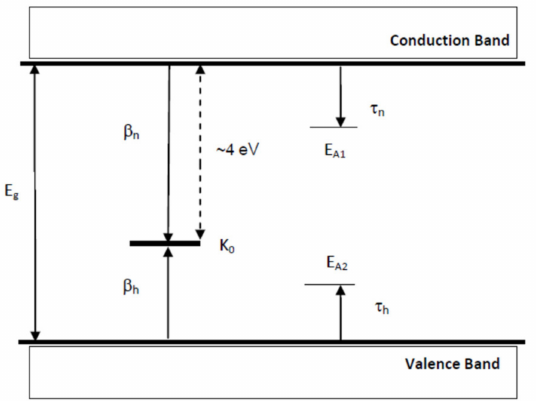
Figure 4. Energy band structure of diamond with some important quantities indicated: E g is the band gap (eV); K 0 indicates a deep trap; β n,h are the decay time of the K 0 deep level (for electrons and holes, respectively); E A 1 and E A 2 indicate the energy levels of shallow traps for electrons and holes, respectively; τ n and τ h are the trapping times for E A 1 and E A 2 levels,